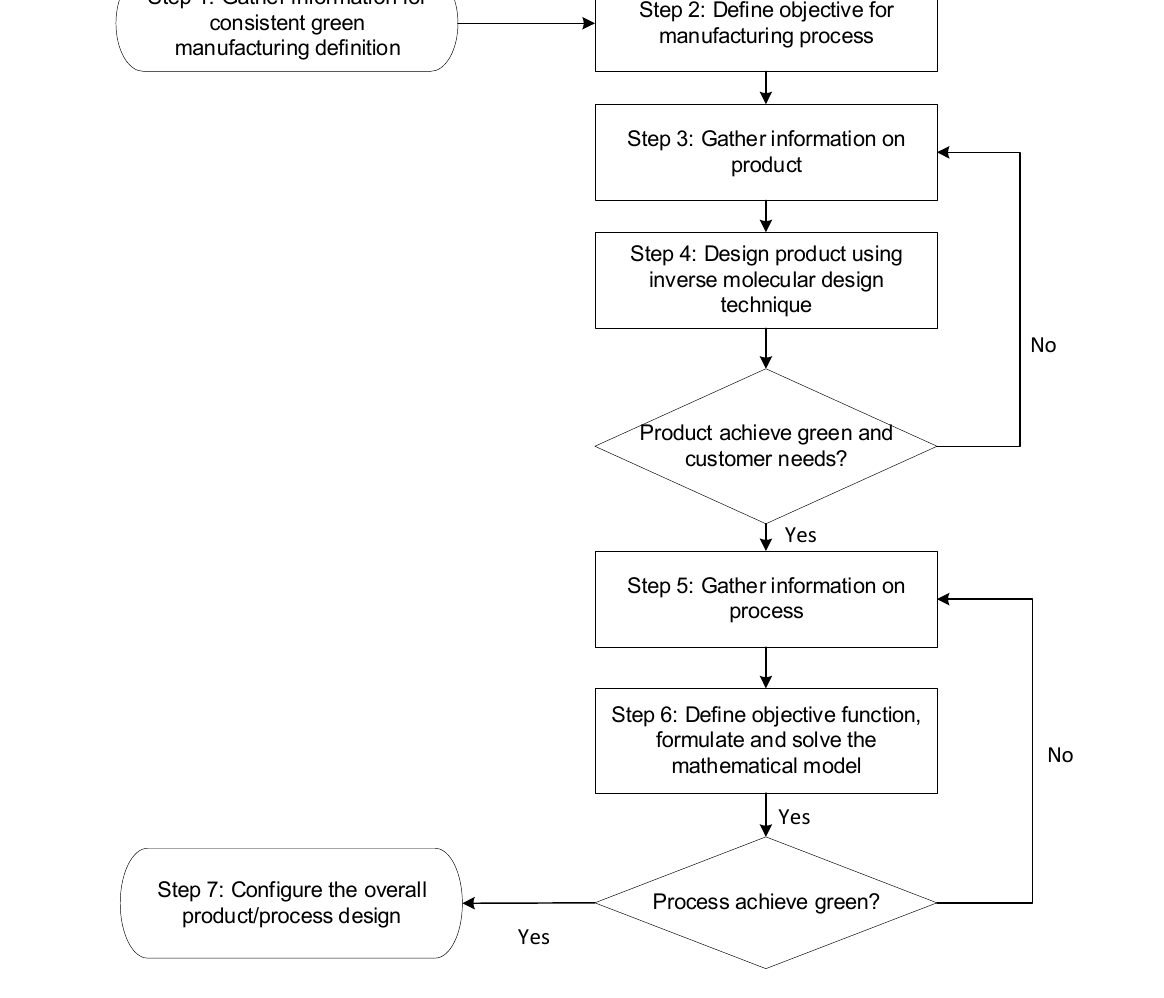
Figure 1. Procedure to incorporate green manufacturing into product and process design. Step 1: Gather information for consistent green manufacturing definition.